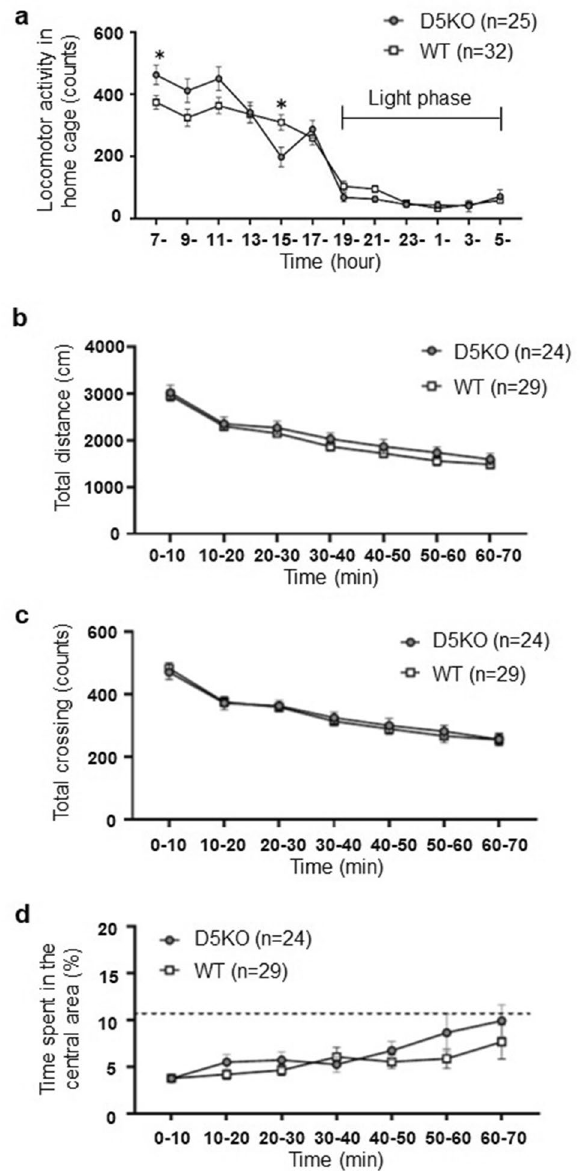
Figure 2. Effects of genotype on 24 h locomotor activity in home cages and on parameters in the open field test. ( a ) Home cage locomotor activity of D5KO mice and wildtype littermates every 2 h. * p < 0.05. ( b ) The total distance traveled in the open field test was divided into seven time phases (10 min bins). ( c ) The number of total crossings (crossings of the lines made by the division of the field [45 × 45 cm] into 7.5 cm × 7.5 cm squares) in the open field test was divided into seven time phases (10 min bins). ( d ) The percentage of time spent in the central area, a measure of decreased anxiety-like behavior in the open field test, was divided into seven time phases (10 min bins). The filled circles indicate D5KO mice and white squares indicate WT littermates. The data are presented as the means ±